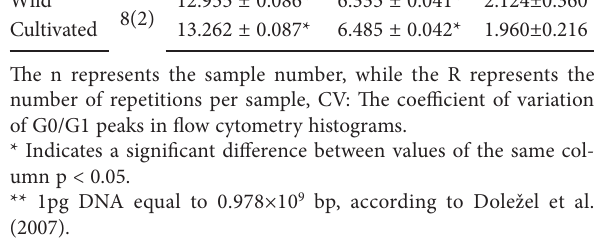
rDNA region and was favored by the selective breed-